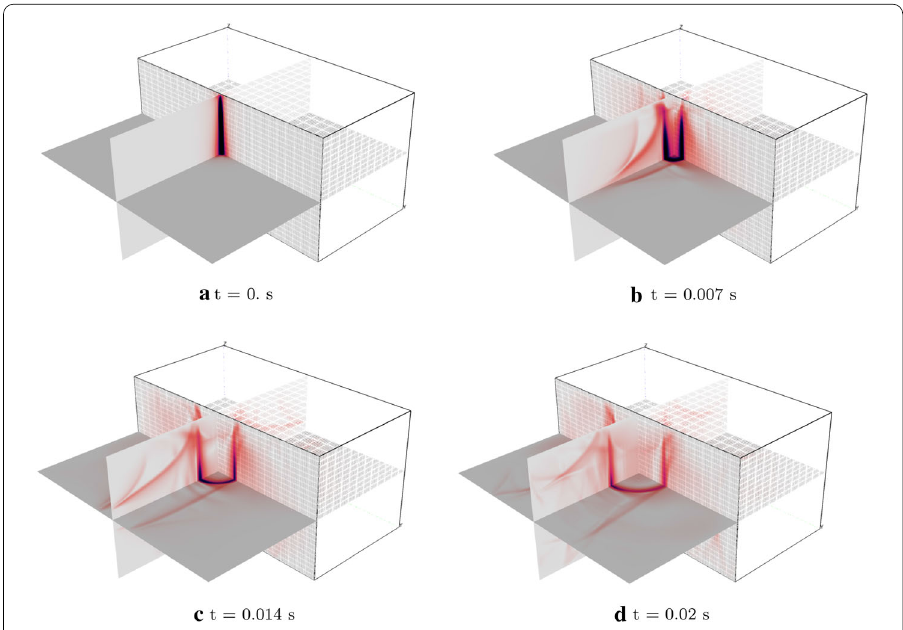
Fig. 13 Elastic wave propagation in a three-dimensional transversely isotropic medium (absolute value of the displacement field)